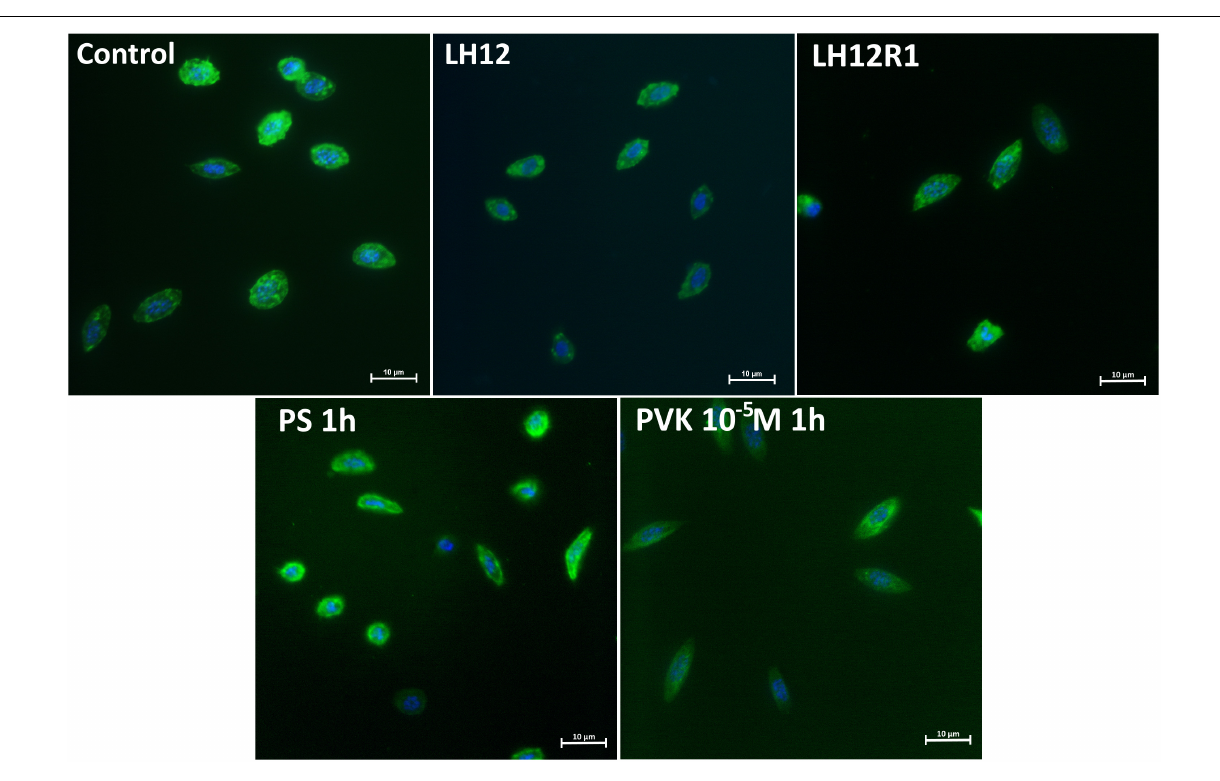
FIGURE 2 | Representative fluorescent micrographs of N. vespilloides haemocytes after 12-h low-humidity treatment (LH12), 1 h of recovery (LH12R1), and 1 h after injection of physiological saline (PS) and Tenmo–PVK-2 at concentrations of 10 − 5 M. Green: F-actin cytoskeleton stained with Oregon Green R (cid:13) phalloidin; blue: haemocyte nuclei visualized using DAPI